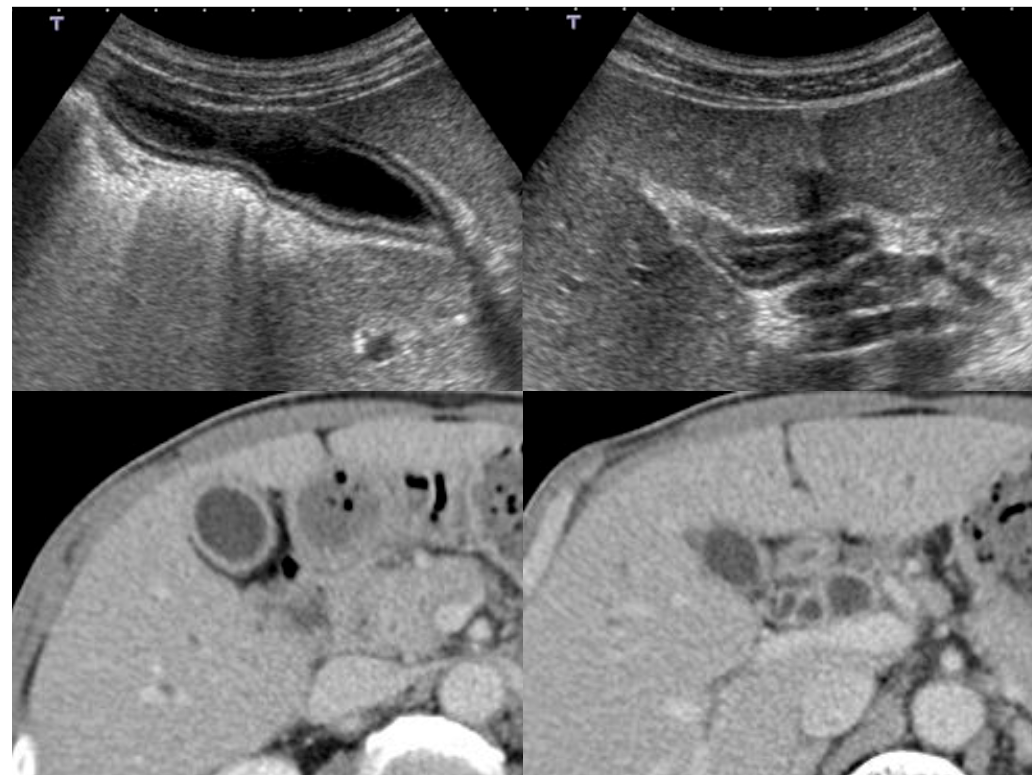
Figure 2. US (3-layer type) and CT (2-layer type) findings of a case with a diffuse type of IgG4-sclerosing cholecystitis. Diagnostics 2021 , 11 , x FOR PEER REVIEW